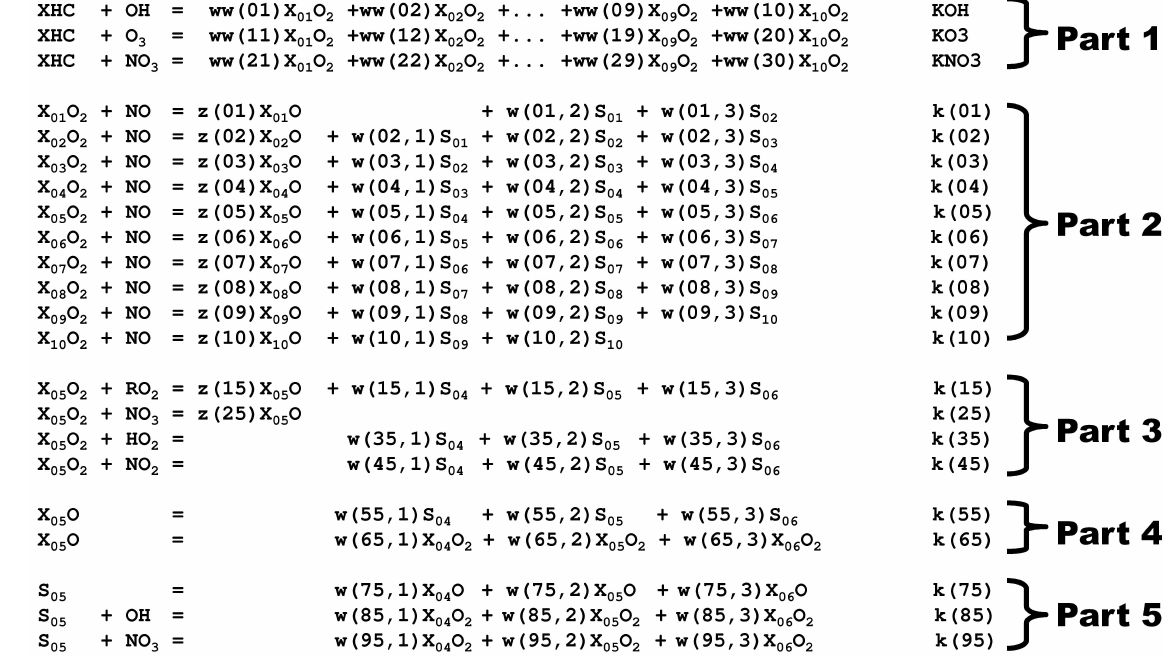
Fig. 1. A simple unified volatility-based scheme (SUVS) for SOA